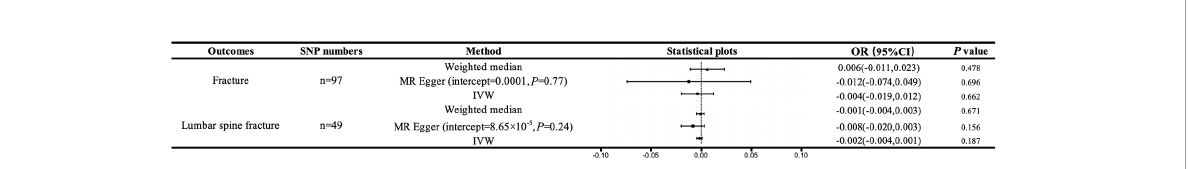
FIGURE 4 Casual associations between hand grip strength and fracture. IVW, inverse variance weighted; MR Egger, mendelian randomization egger; CI, con fi dence interval; BMD, bone mineral density; SNP, single nucleotide